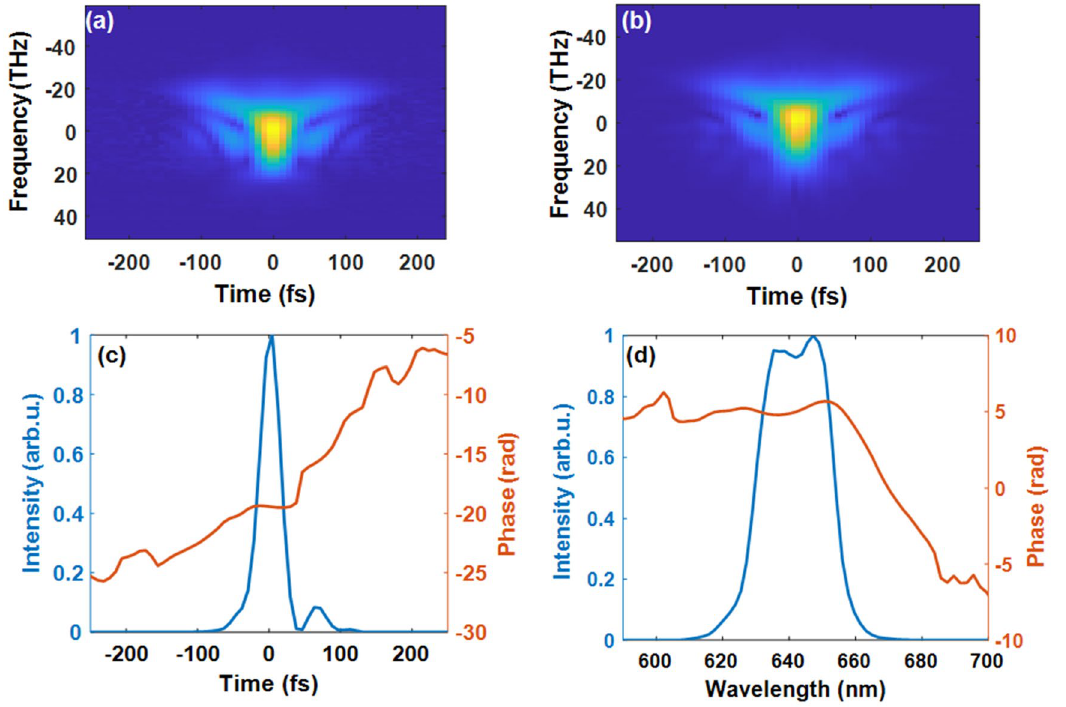
Figure 2. Measured ( a ) and retrieved ( b ) FROG traces (electric field amplitudes) from the input NOPA pulse. ( c ) Retrieved temporal intensity profiles and phases. ( d ) Retrieved spectral intensity profiles and phases. N = 96 , T = 400, dt = 8.4211 fs .